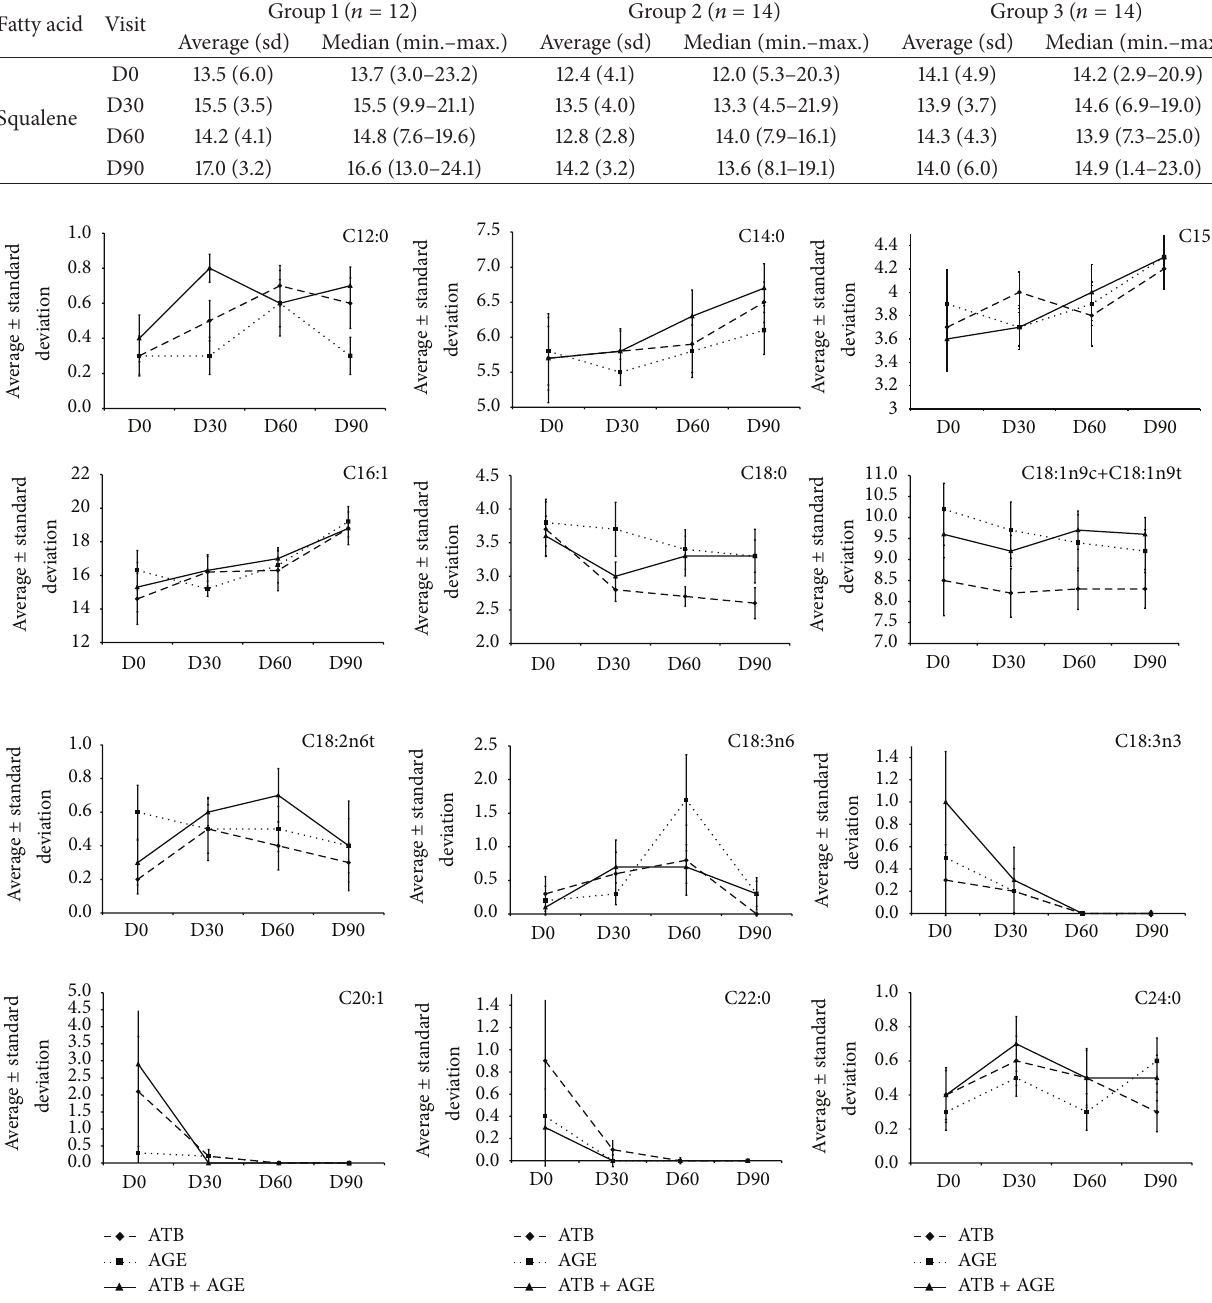
Figure 2: Graphic representation of fatty acids which showed differences in chromatographic pattern during the study.